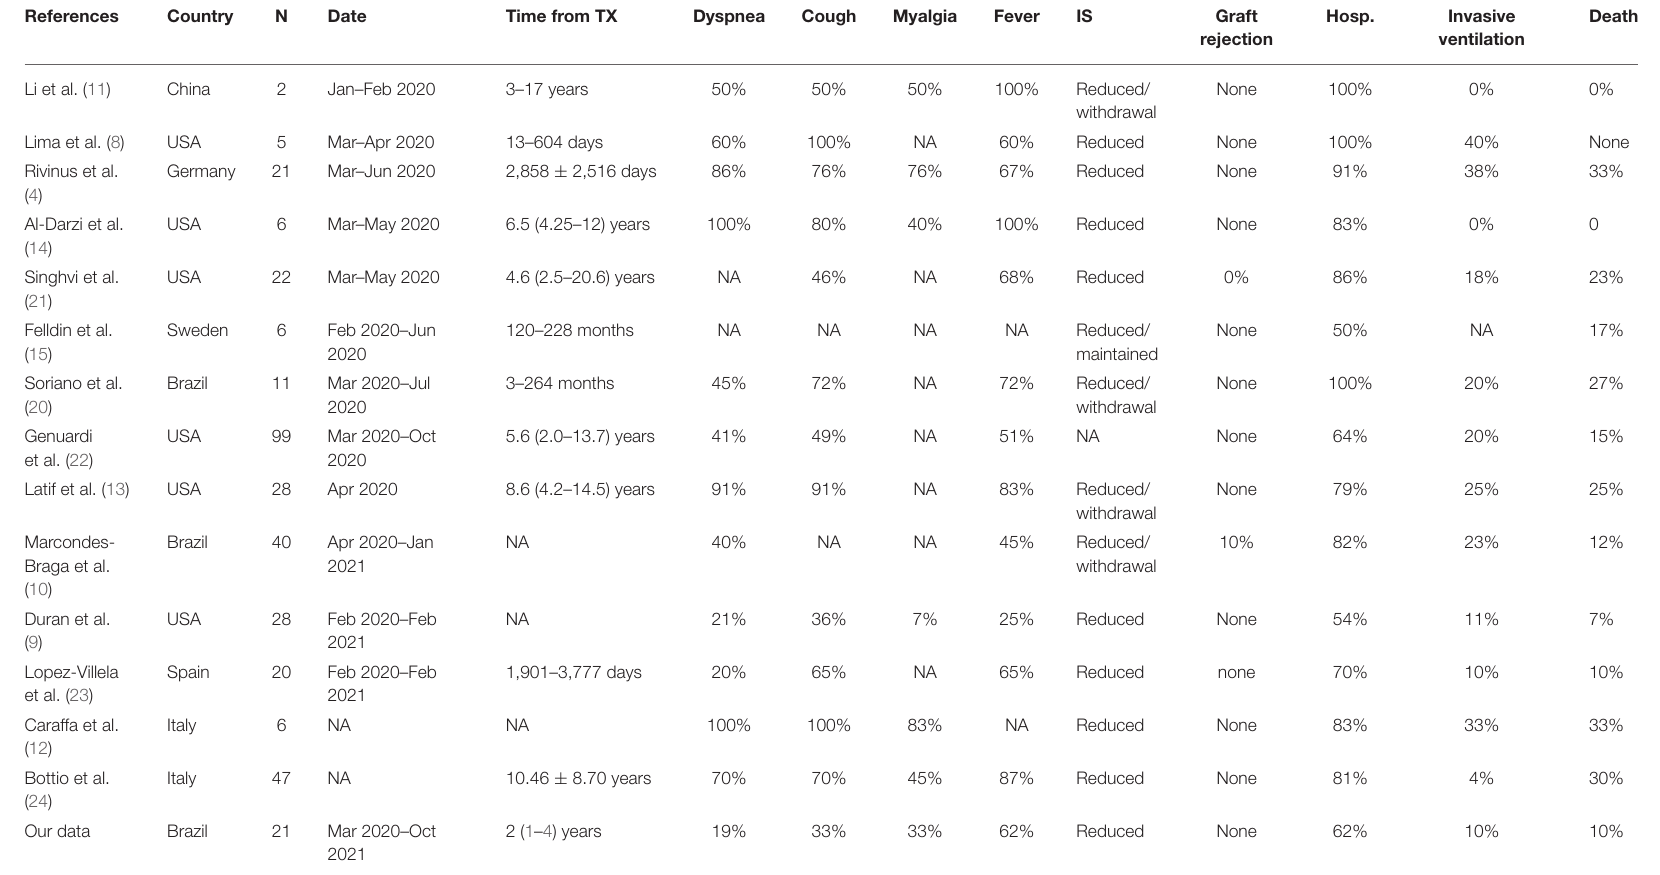
TABLE 3 | Demographics, clinical characteristics and outcomes from previously published cohorts of heart transplant recipients infected with COVID-19.